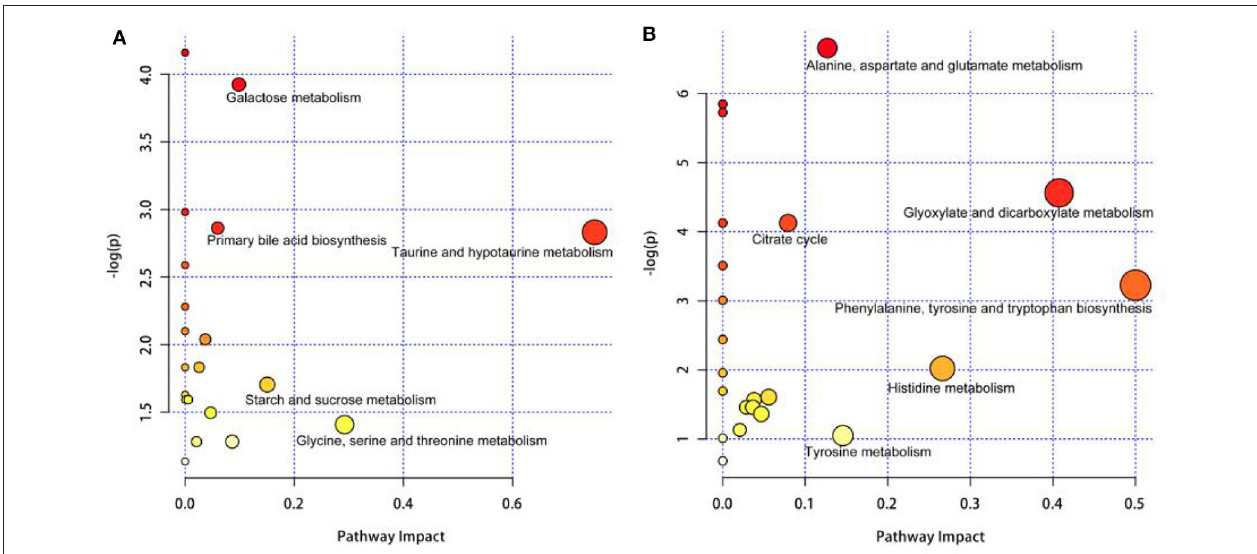
FIGURE 4 | Pathway analysis of the differential metabolites in the milk whey and serum of group B cows. Bubble area is proportional to the impact of each pathway, with color denoting the significance from highest in red to lowest in white. (A) Pathway analysis of the differential metabolites in the milk whey. (B) Pathway analysis of the differential metabolites in the